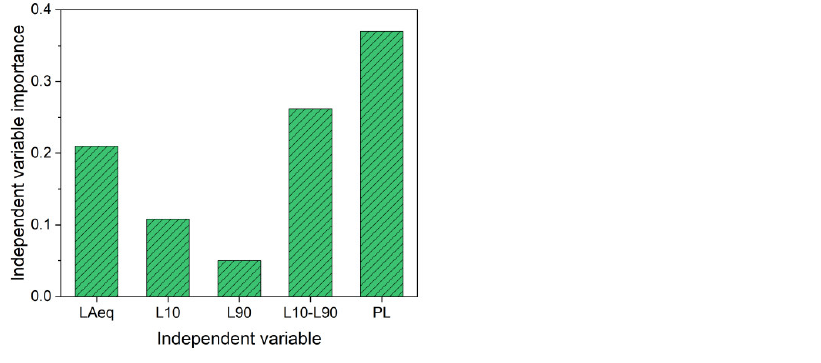
Figure 6. Importance of input indicators in determining the output value of soundscape.